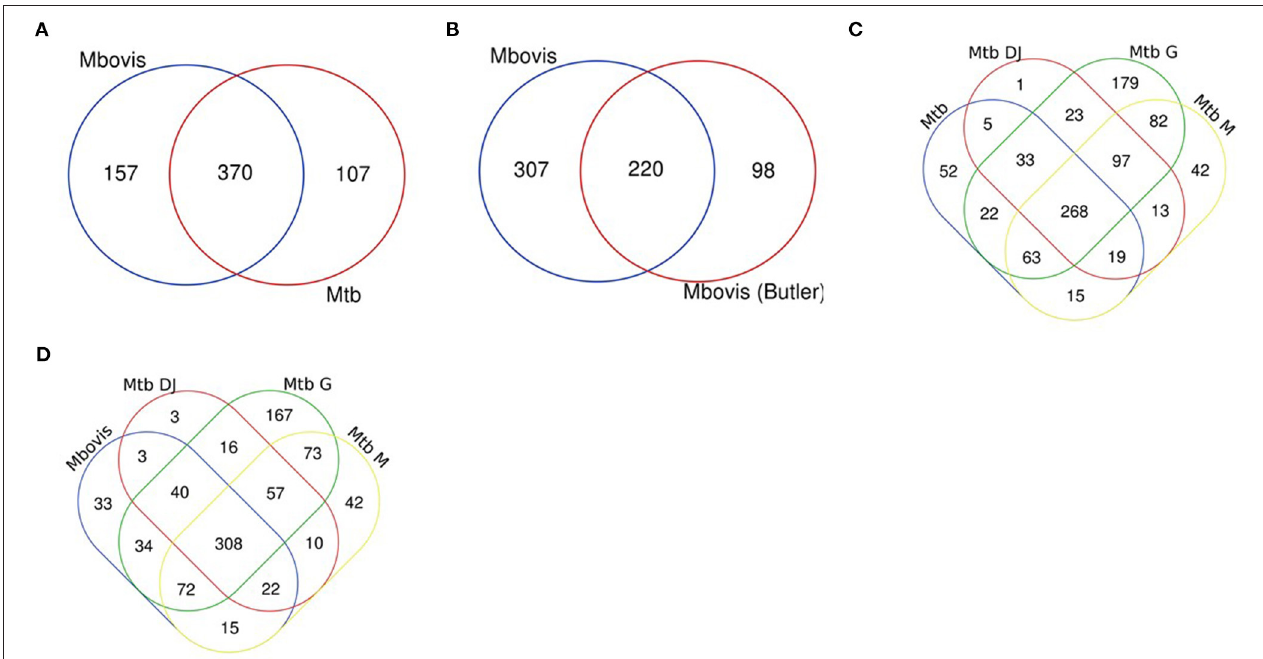
FIGURE 2 | Essential gene comparisons. Gene essentiality was determined for M. bovis and M. tuberculosis using custom HMM analyses with TRANSIT software and compared to previously published datasets. (A) M. bovis and M. tb (both this study), (B) M. bovis (this study) and M. bovis ( 26) (C) M. tb (this study) and M. tb DJ ( 23), M. tb G (22) and M. tb M (21) and (D) M. bovis (this study) and M. tb DJ (23), M. tb G (22) and M. tb M